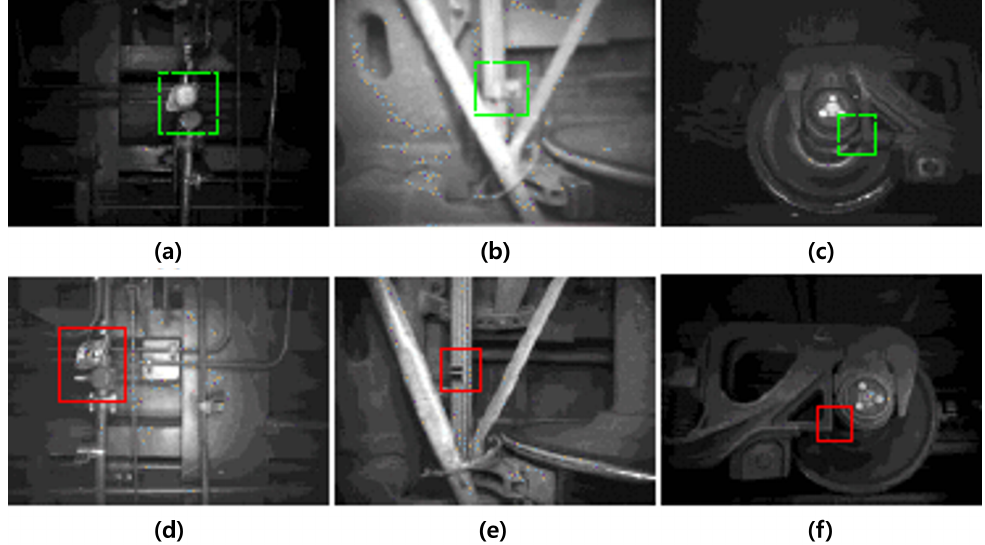
Figure 7. Some typical samples of the vehicle brake system of freight trains. ( a – c ) Normal images. ( d ) Dirt collector damaged and cut-out cock handle closed (the handle of cut-out cock is not visible in a normal image). ( e ) The absence of fastening bolt. ( f ) Bogie block key missing. Reproduced with permission from IEEE